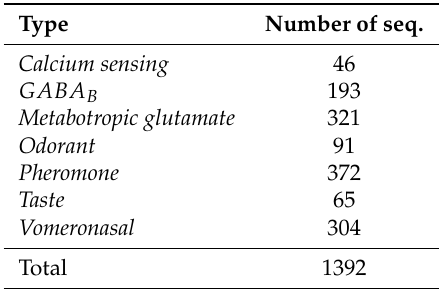
Table 1. Distribution of the unaligned class C GPCRs. Type Number of seq.